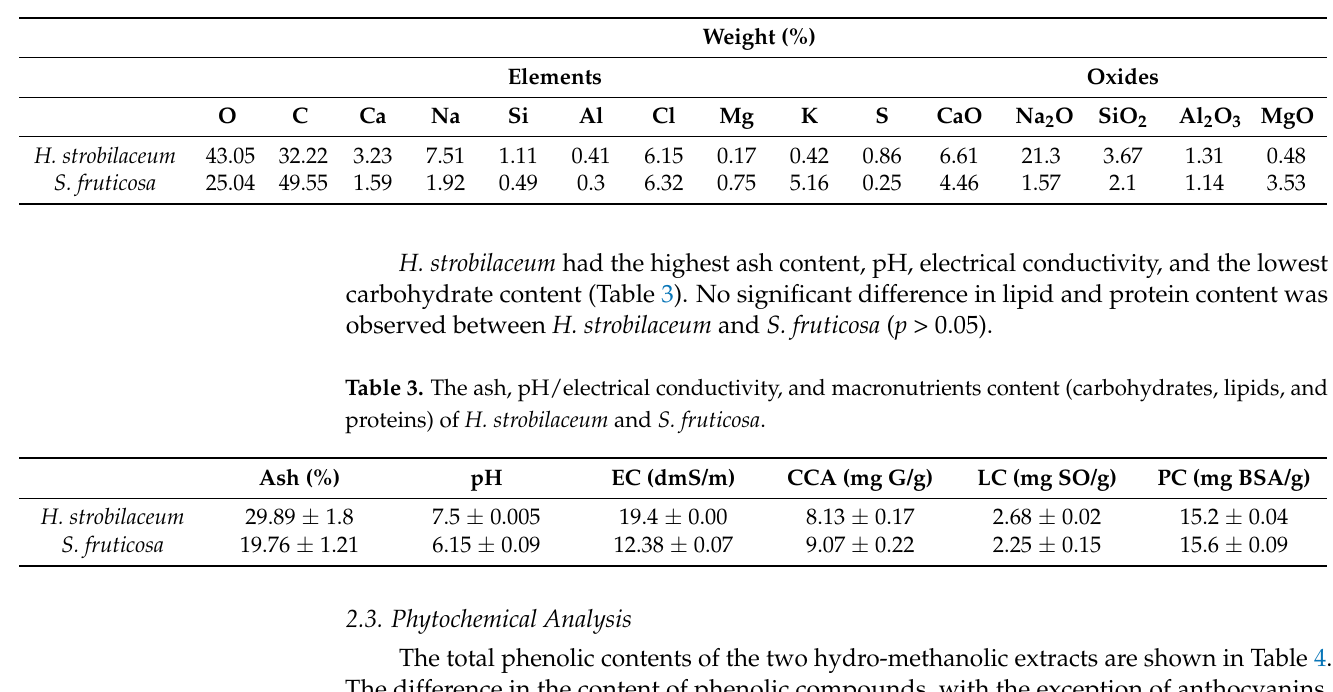
Table 2. SEM-EDX analyses for the dry matter of the aerial part of H. strobilaceum and S. fruticosa .